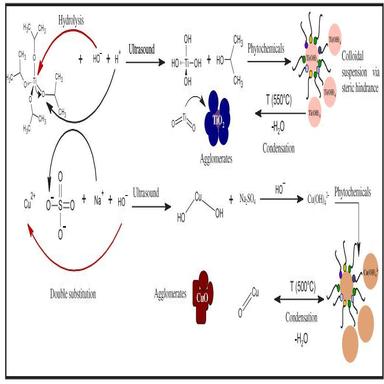
Proposed mechanism for the green synthesis of TiO2 and CuO nanoparticles using an aqueous extract of Moringa Oleifera. Source: Reactions from: Schlur et al. and Solano et al..